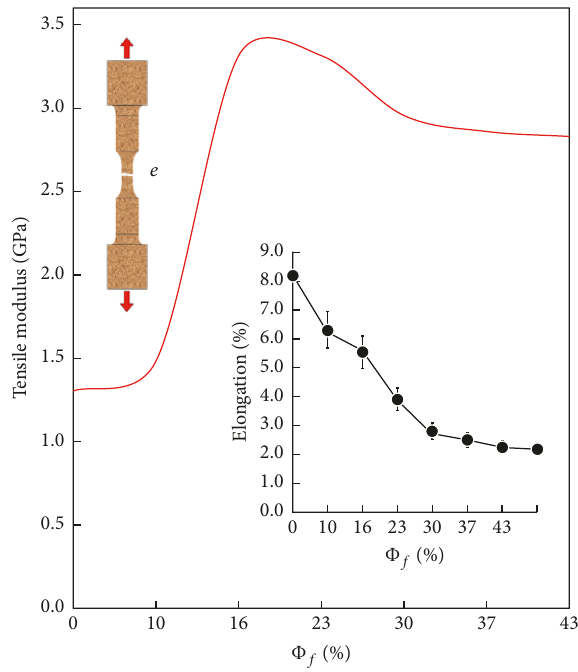
Figure 9: Tensile modulus and elongation for Φ 𝑓 % curves of the composites mixture.